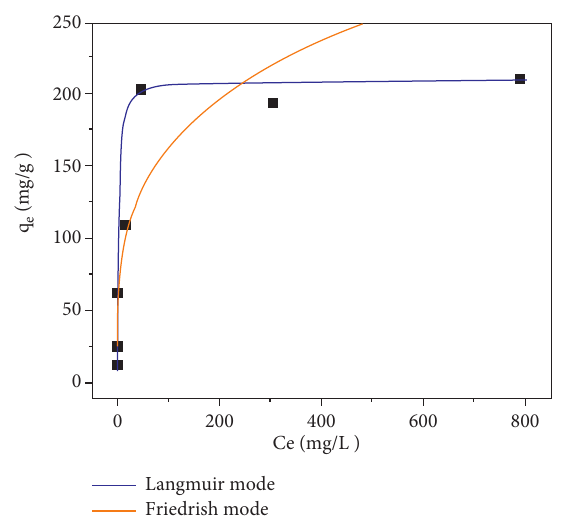
Figure 9: Adsorption isotherms of Co(II) ions on the GTNT composites and the corresponding Langmuir and Freundlich fitting. Table 2: Langmuir and Freundlich adsorption isotherm parameters for Co(II) ions on the GTNT composites. Equations